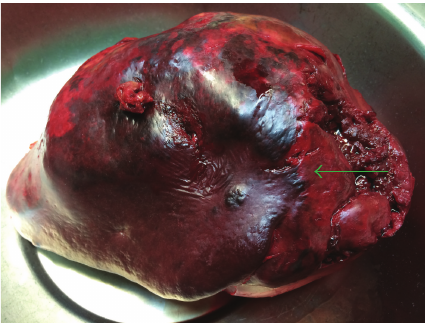
Figure 2: Microscopic view of splenic angiosarcoma (Hematoxylin- Eosin stain, H-E × 200). Area of atypical endothelial cells with significant irregular hyperchromatic nuclei (green arrow), area of necrosis (red arrow).